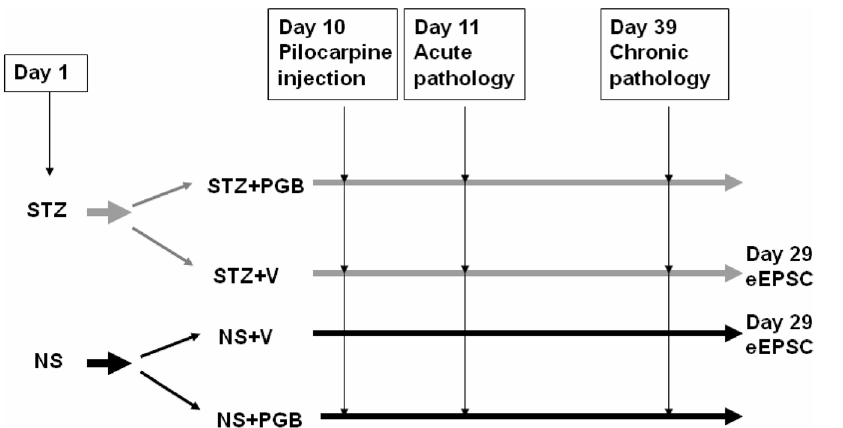
Figure 1. Experimental protocol. Pilocarpine (60 mg/kg; s.c.) was administered to induce seizures on day 10 (n=30 in each group). Lithium chloride (3 meq/kg; i.p.) and methylscopolamine (25 mg/kg; s.c.) were injected 18–20 h and 30 min before the pilocarpine injection, respectively [12]. Twenty-four hours after pilocarpine-induced status epilepticus (day 11), acute pathological study on neuronal loss was performed (n=5 in each group). Twenty-eight days after status epilepticus (day 39), chronic pathological study on mossy fiber sprouting was performed (n=5 in each group).